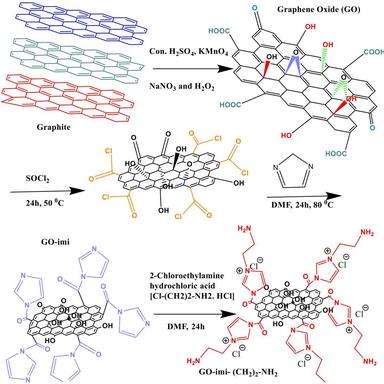
Schematic process of functionalized graphene oxide (GO-imi- (CH2)2-NH2).